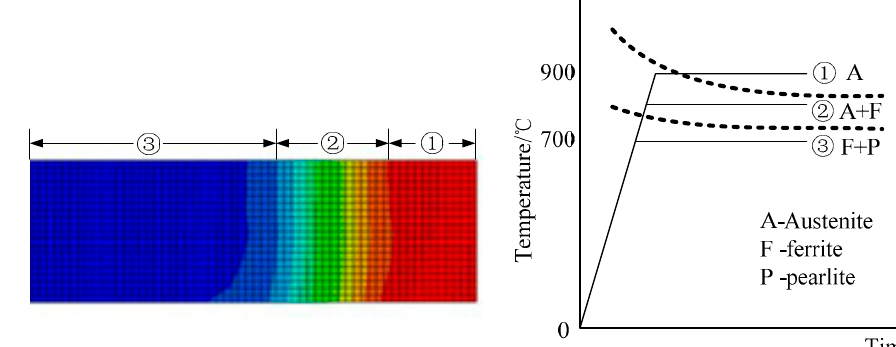
Figure 1. Strategic mechanism of selective heating and press hardening.